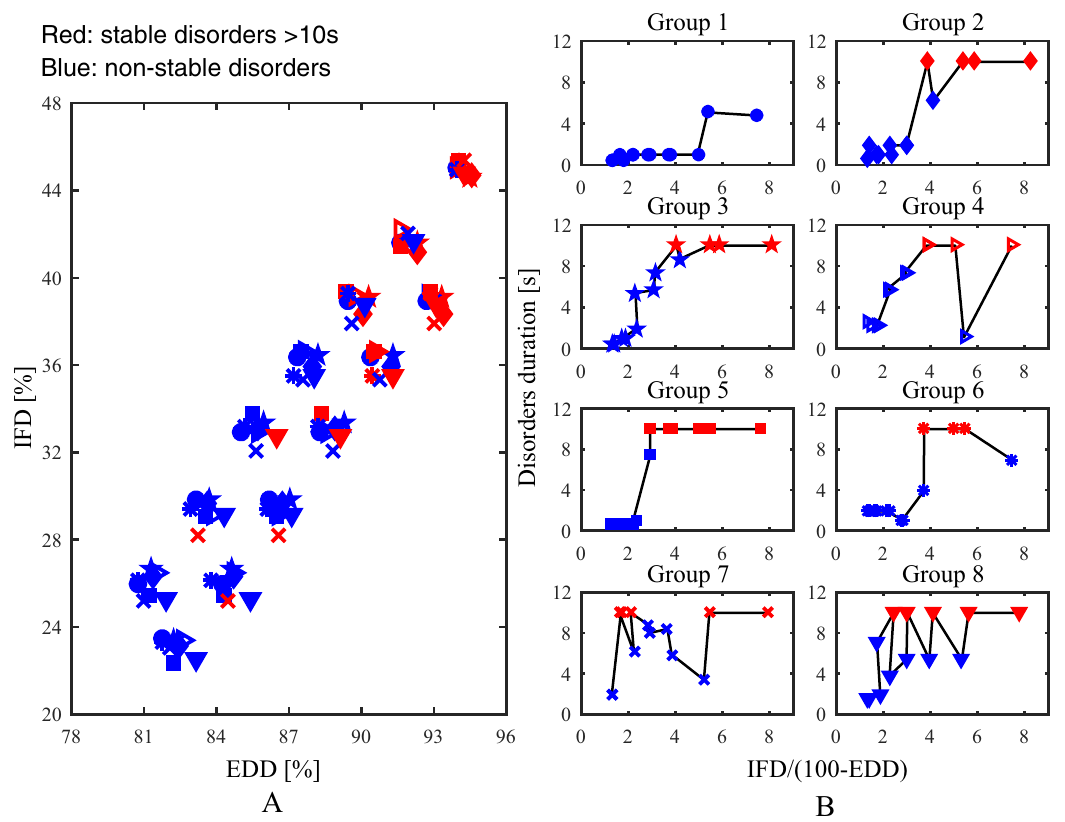
Fig 7. Simulation results of the interrelated groups. (A) A time map of 104 simulations shows effects of intramural fibrosis and endo-epicardial dissociation on stability. (B) Time curves of eight groups show effects of the increase of intramural fibrosis and endo- epicardial dissociation on stability. IFD is the intramural fibrosis degree and EDD is the endo-epicardial dissociation